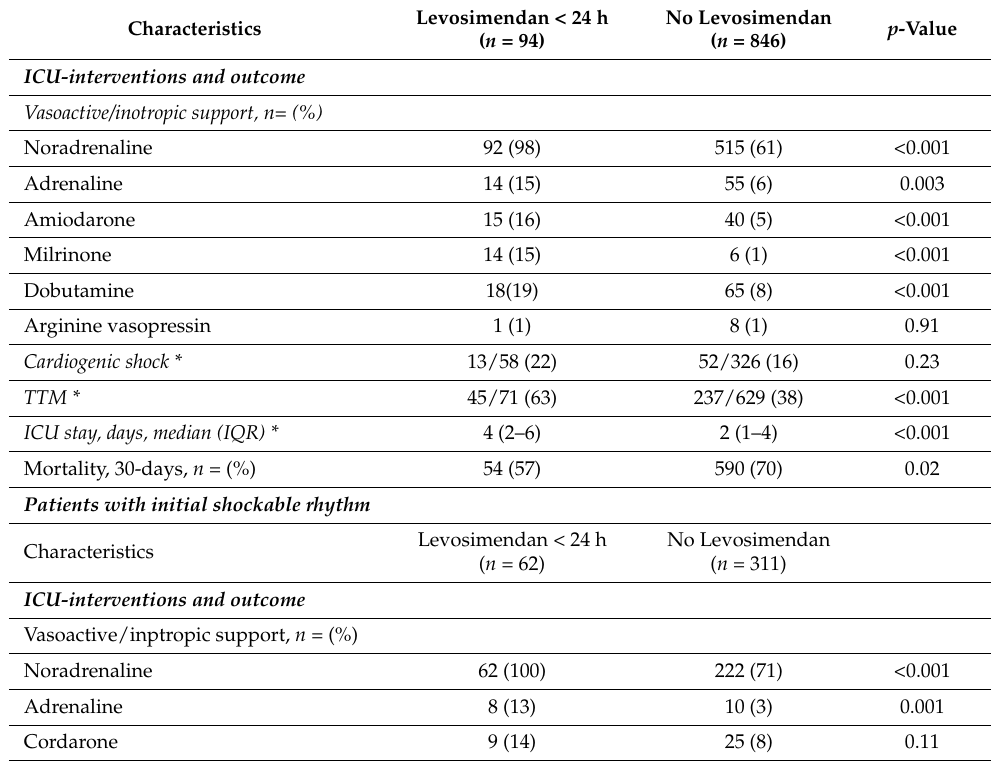
Table 2. Interventions and outcomes in out-of-hospital-cardiac arrest patients admitted to the inten- sive care unit in Stockholm, Sweden,